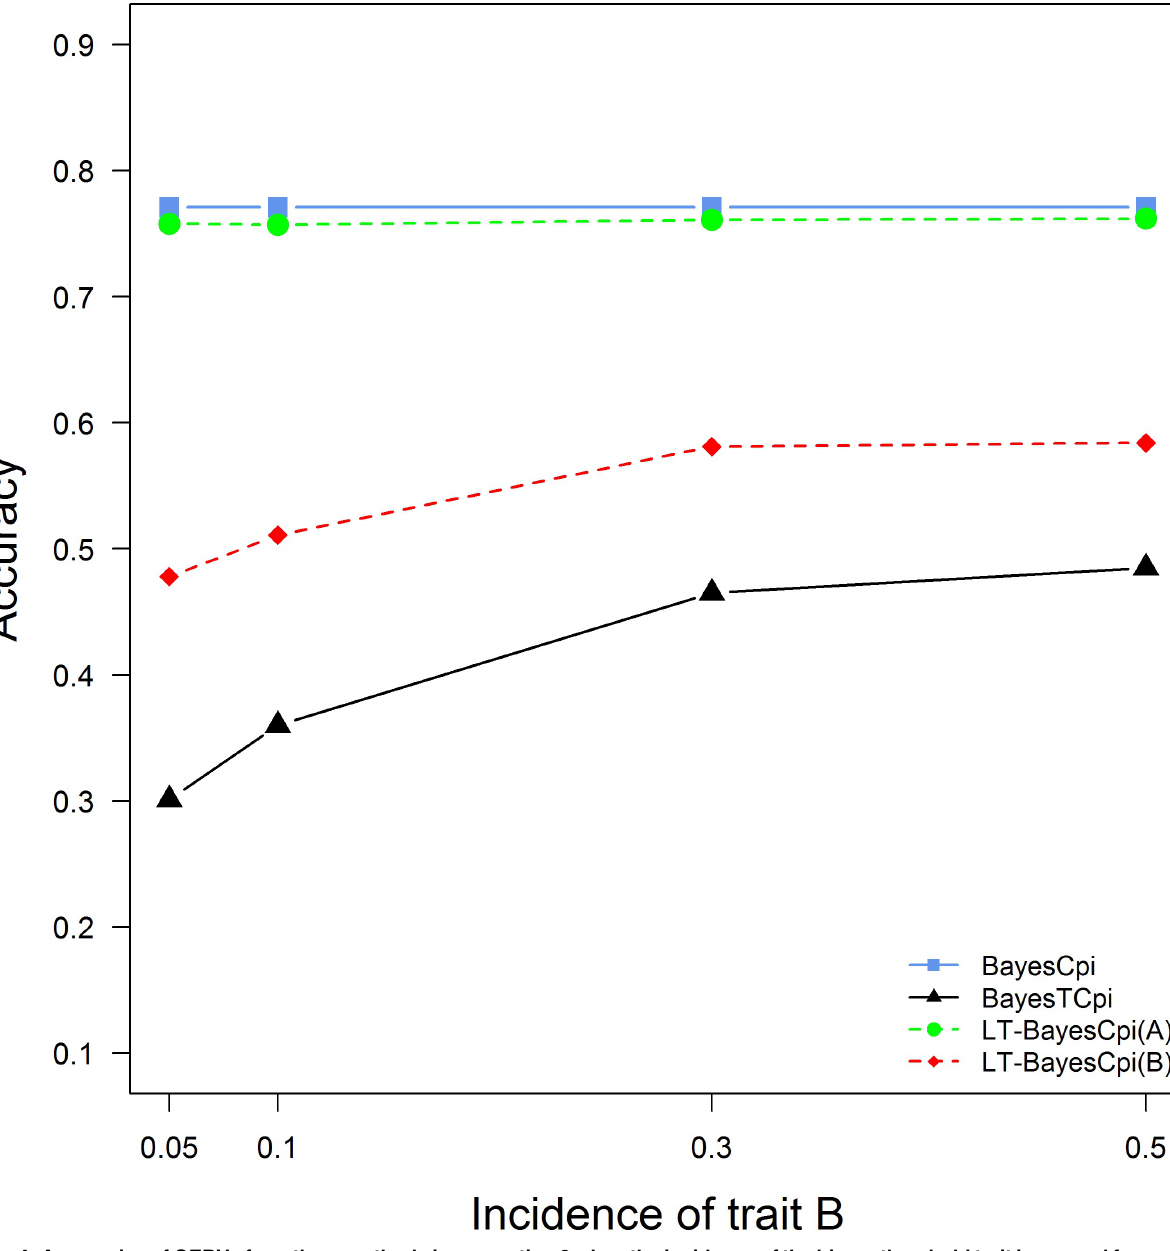
Fig 4. Accuracies of GEBVs from three methods in generation 3 when the incidence of the binary threshold trait increased from 0.05 to 0.5.